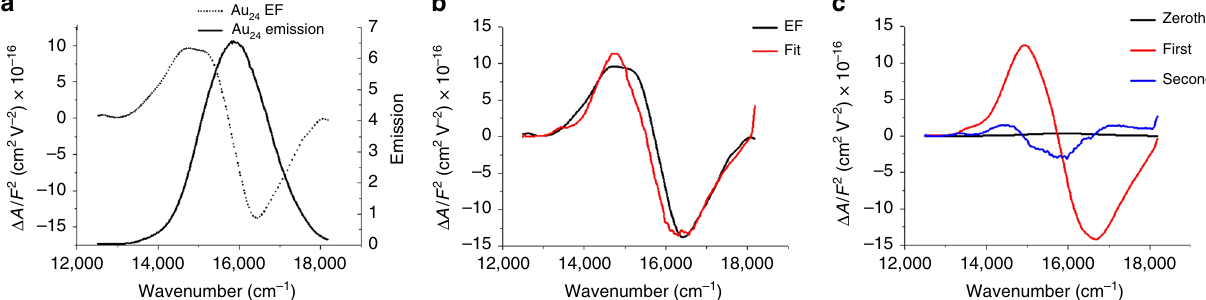
Fig. 5 Stark spectroscopic measurements on Au 24 . a Emission (solid line) and electro fl uorescence (EF; dashed). b EF (black) and fi t (red, the details of the fi tting are described in “ Methods ” ). c EF fi t broken into zeroth, fi rst, and second